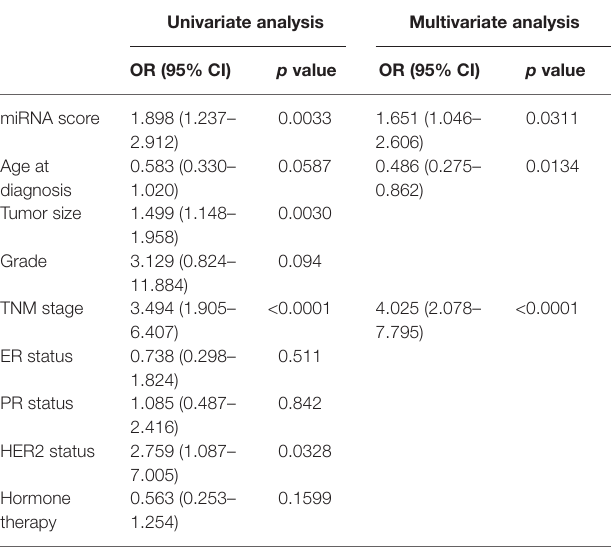
TABLE 2 | Risk factors for lung metastasis (LM) in training cohort.